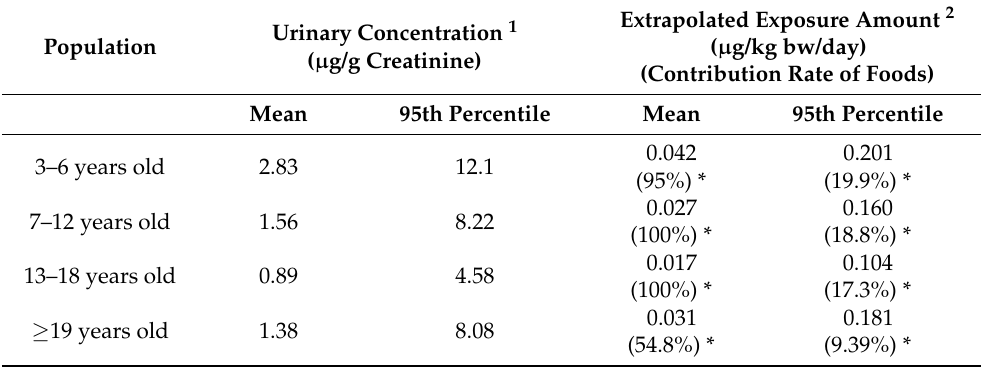
Table 3. Calculated exposure based on urinary bisphenol A concentration of Korean general population.